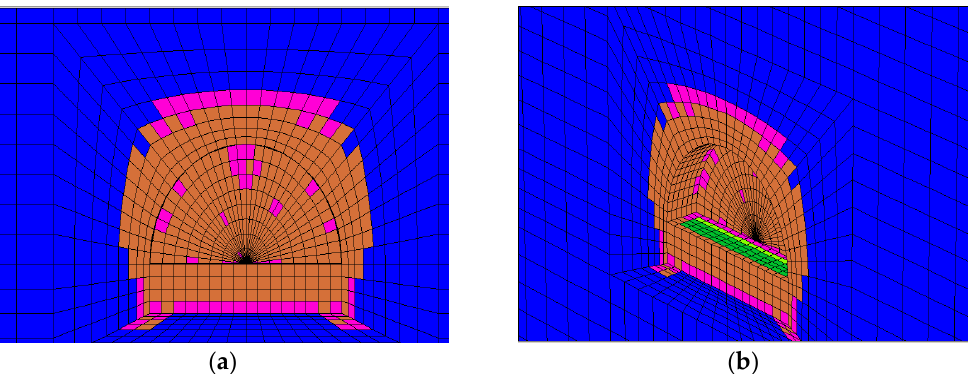
Figure 17. Numerical calculation of loose circle for electronic detonator blasting excavation. ( a ) Plane view; ( b ) 3D view.